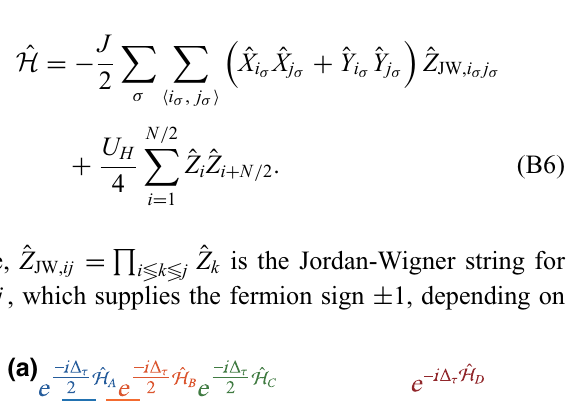
FIG. 13. (a) Circuit structure of the lowest-order Suzuki-Trotter-decomposed time-evolution operator Fermi-Hubbard model considered here in Eq. (B6). The gate K denotes the exponentiated hopping term defined in (b), while the gate V denotes the exponentiated interaction term defined in (c). Here, only the part corresponding to the first four exponentials is shown. (b) Decomposition of the K gate that represents exp[ − i θ( ˆ X i ˆ X j + ˆ Y i ˆ Y j ) ˆ Z JW, ij / 2] operating at qubits i and j as well as all qubits between these two qubits. The gate XY represents exp[ − i θ( ˆ X i ˆ X j + ˆ Y i ˆ Y j )/ 2] operating at qubits i and j . The gate R X ( Y ) (θ) is given by R X ( Y ) (θ) = exp[ − i θ ˆ X i ( ˆ Y i )/ 2] operating at qubit i . (c) Decomposition of the V gate that represents exp[ − i φ ˆ Z i ˆ Z j / 2] operating at qubits i and j . The gate R Z (φ) is given by R Z (φ) = exp[ − i φ ˆ Z i / 2] operating at qubit i . Here, θ = − (cid:3) τ J / 2 and φ = (cid:3) τ U H / 2 for the Fermi-Hubbard model given in Eq.